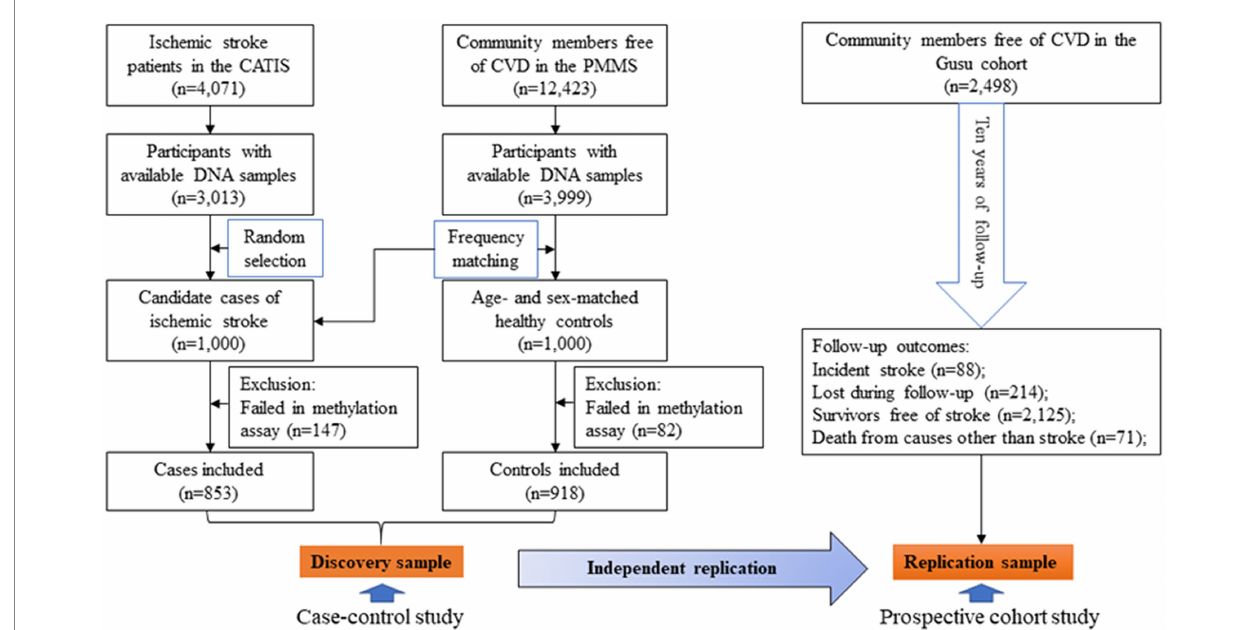
FIGURE 1 A flowchart illustrating the selection of study participants. CATIS, China Antihypertensive Trial in Acute Ischemic Stroke; CVD, cardiovascular disease; PMMS, Prevention of Metabolic syndrome and Multi-metabolic disorders Study.